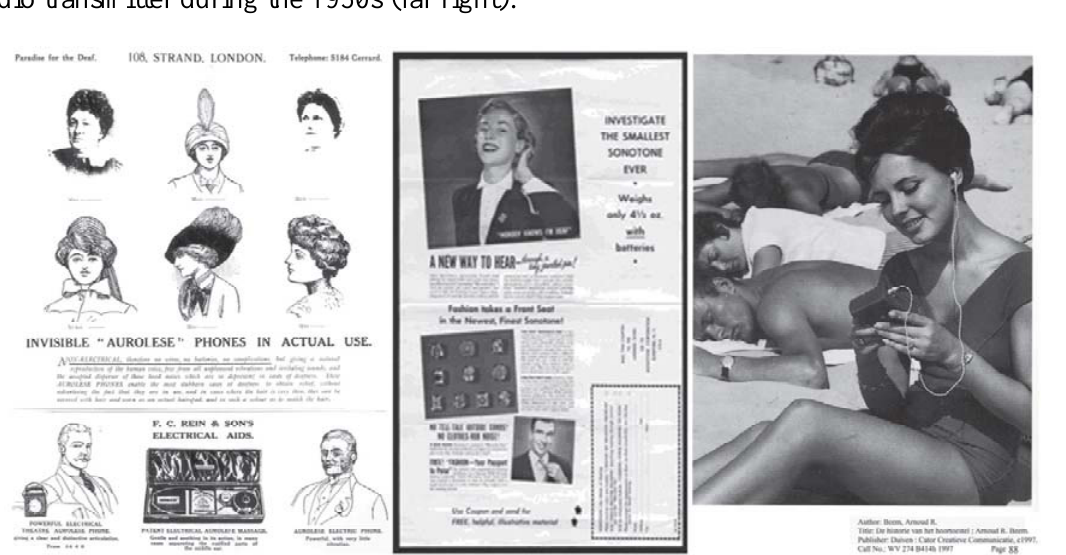
Figure 1. Different aurolese phones intended to hide devices for the deaf during the 19th century (two photos on the left) & a technological device for the deaf intended to mask as a radio transmitter during the 1950s (far